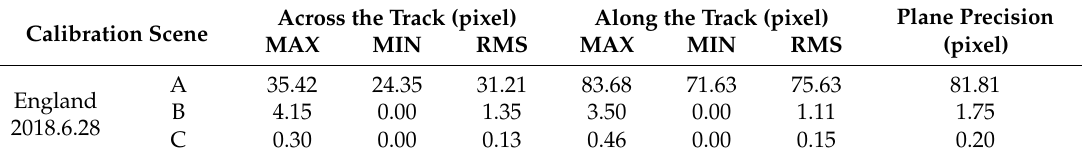
Table 4. Calibration